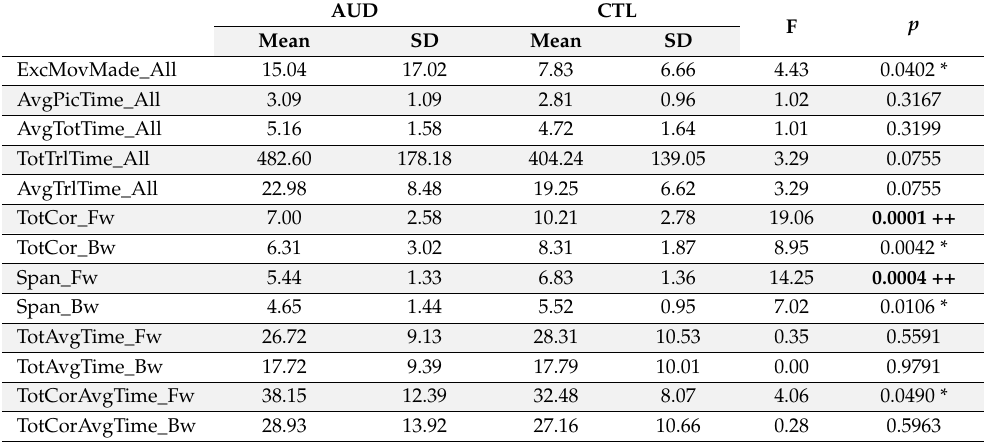
Table 5. Comparison of neuropsychological variables between AUD or CTL group using one- way